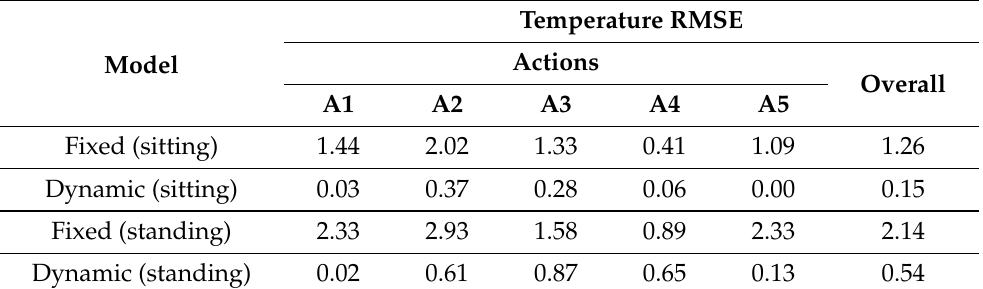
Table 5. The temperature RMSE of the proposed and traditional models in terms of actions period and average